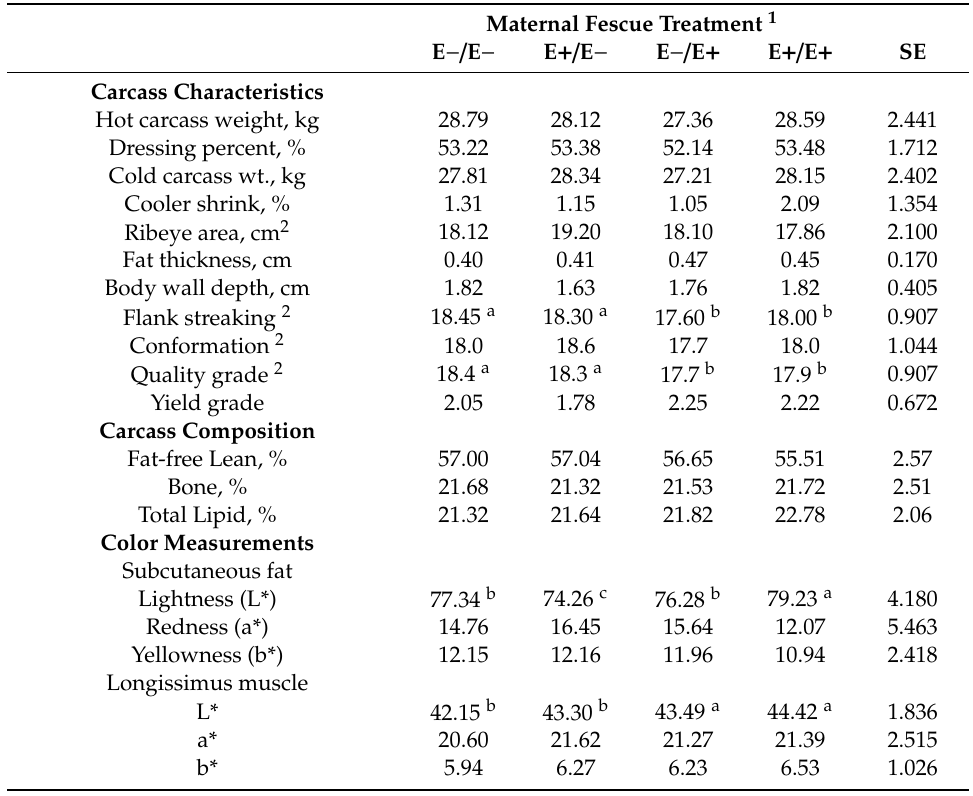
Table 3. Post-weaning carcass composition and color measurements of wethers born to ewes consuming endophyte-infected (E + ) or endophyte-free (E − ) fescue during MID (d 35-85) and / or LATE (d 86- parturition)